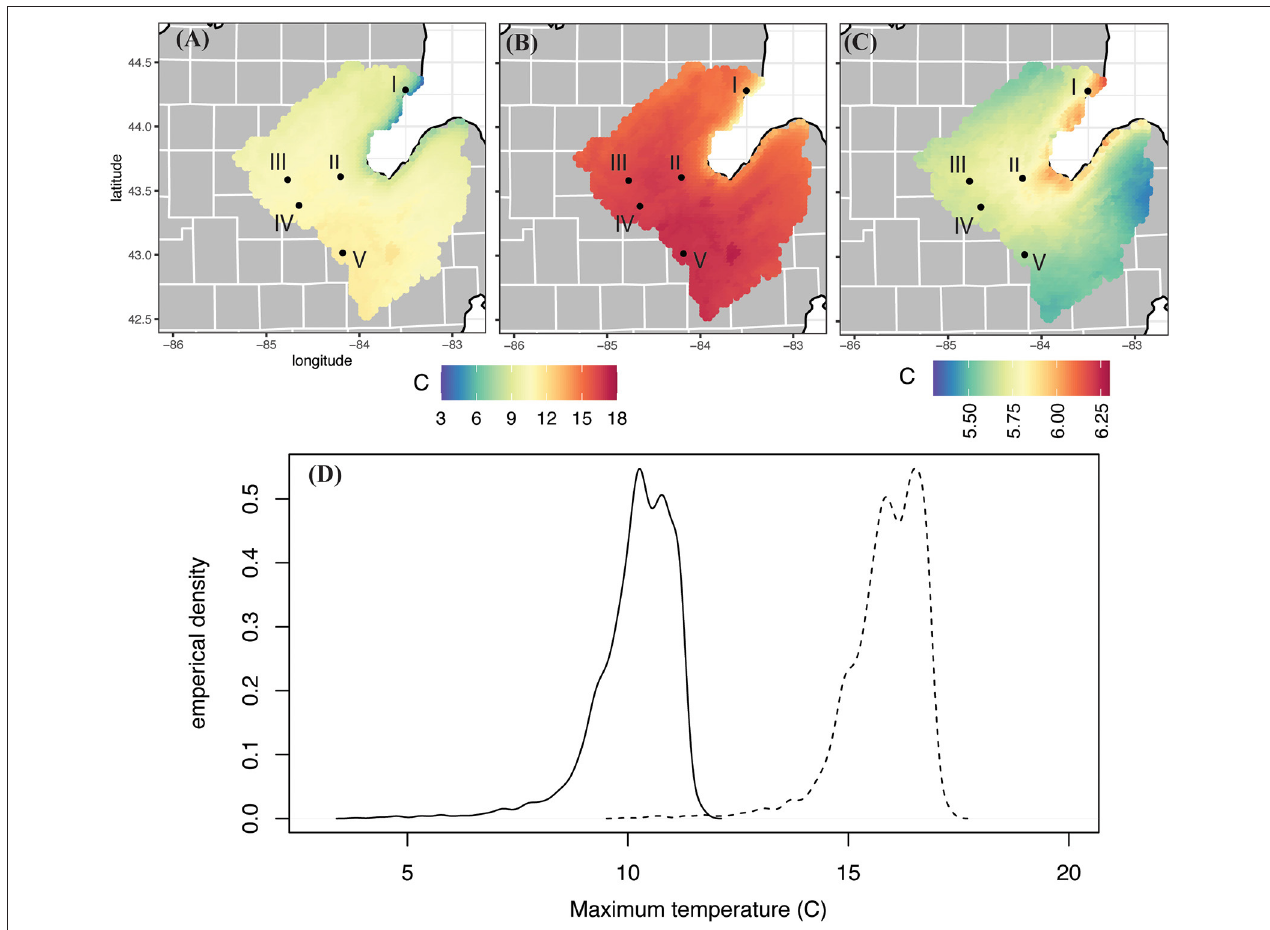
FIGURE 2 | Uncorrected WRF output of mean maximum daily temperature ( ◦ C) from (A) the 1991–2005 historical climate run; (B) the 2085–2099 future RCP 8.5 scenario; (C) the difference between the (A) and (B) future–past and (D) the empirical distribution from all of the grid cells in the watershed for mean maximum daily temperature for (A) (solid line) and (B) (dashed